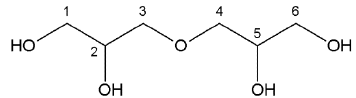
Figure 3. The effect of catalyst concentration on the observed mass distribution for the synthesized oligoglycerols, as determined from the ESI-MS spectra of the analyzed samples (m/z = [M − H] − ).